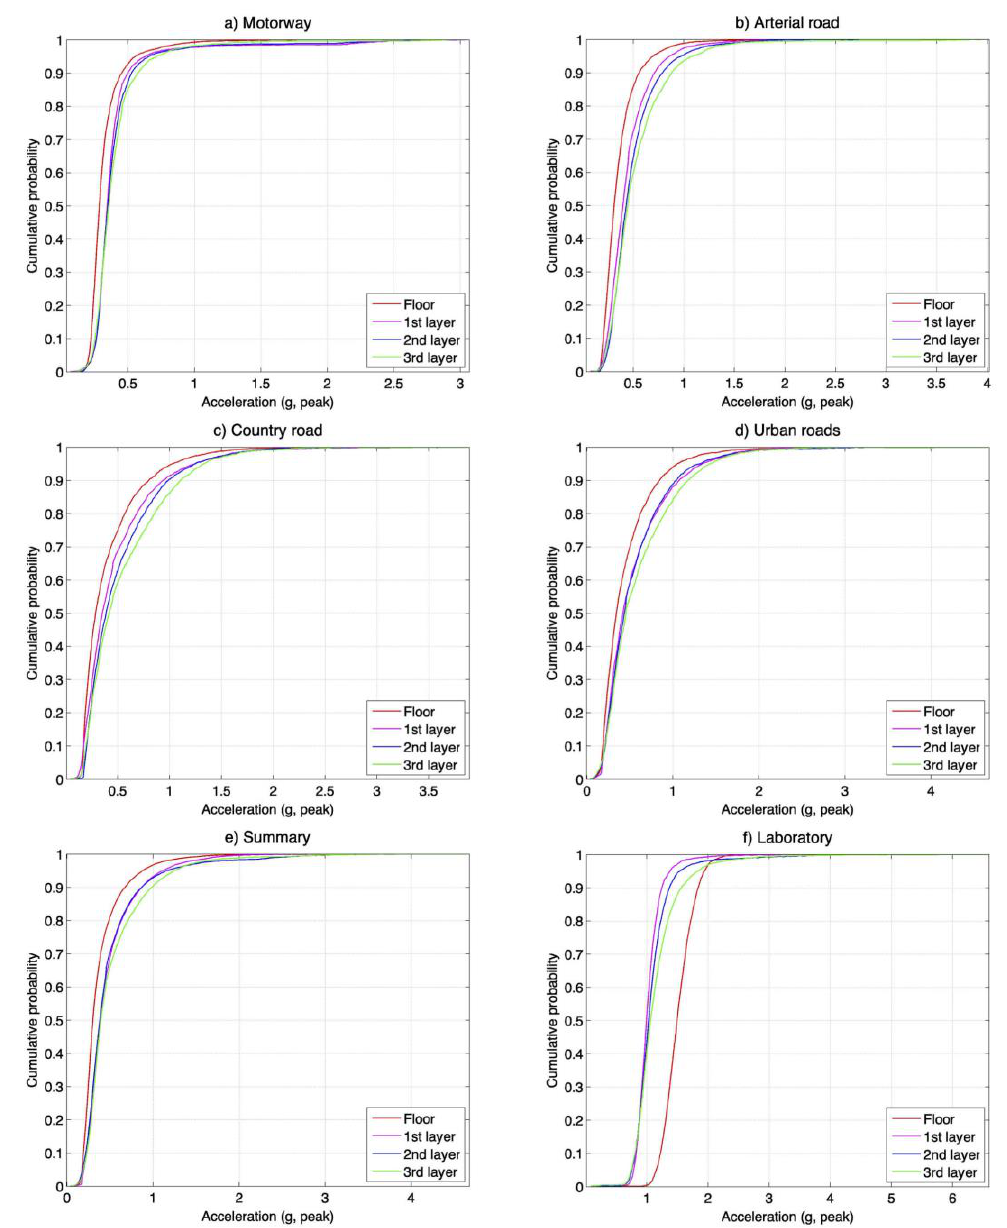
Figure 7. Empirical CDFs of peak acceleration values, ( a ) Motorway, ( b ) Arterial road, ( c ) Country road, ( d ) Urban roads, ( e ) Summary, ( f ) Laboratory.